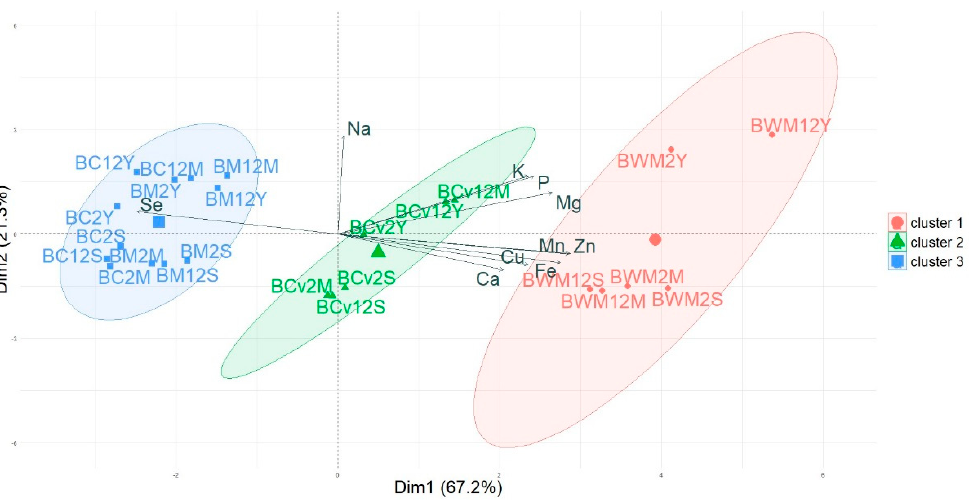
Figure 3. Principal components analysis (PC1 vs. PC2) describing the variation among the breads manufactured with different wheat flours (Group 1: BWM breads, group 2: BCv breads and group